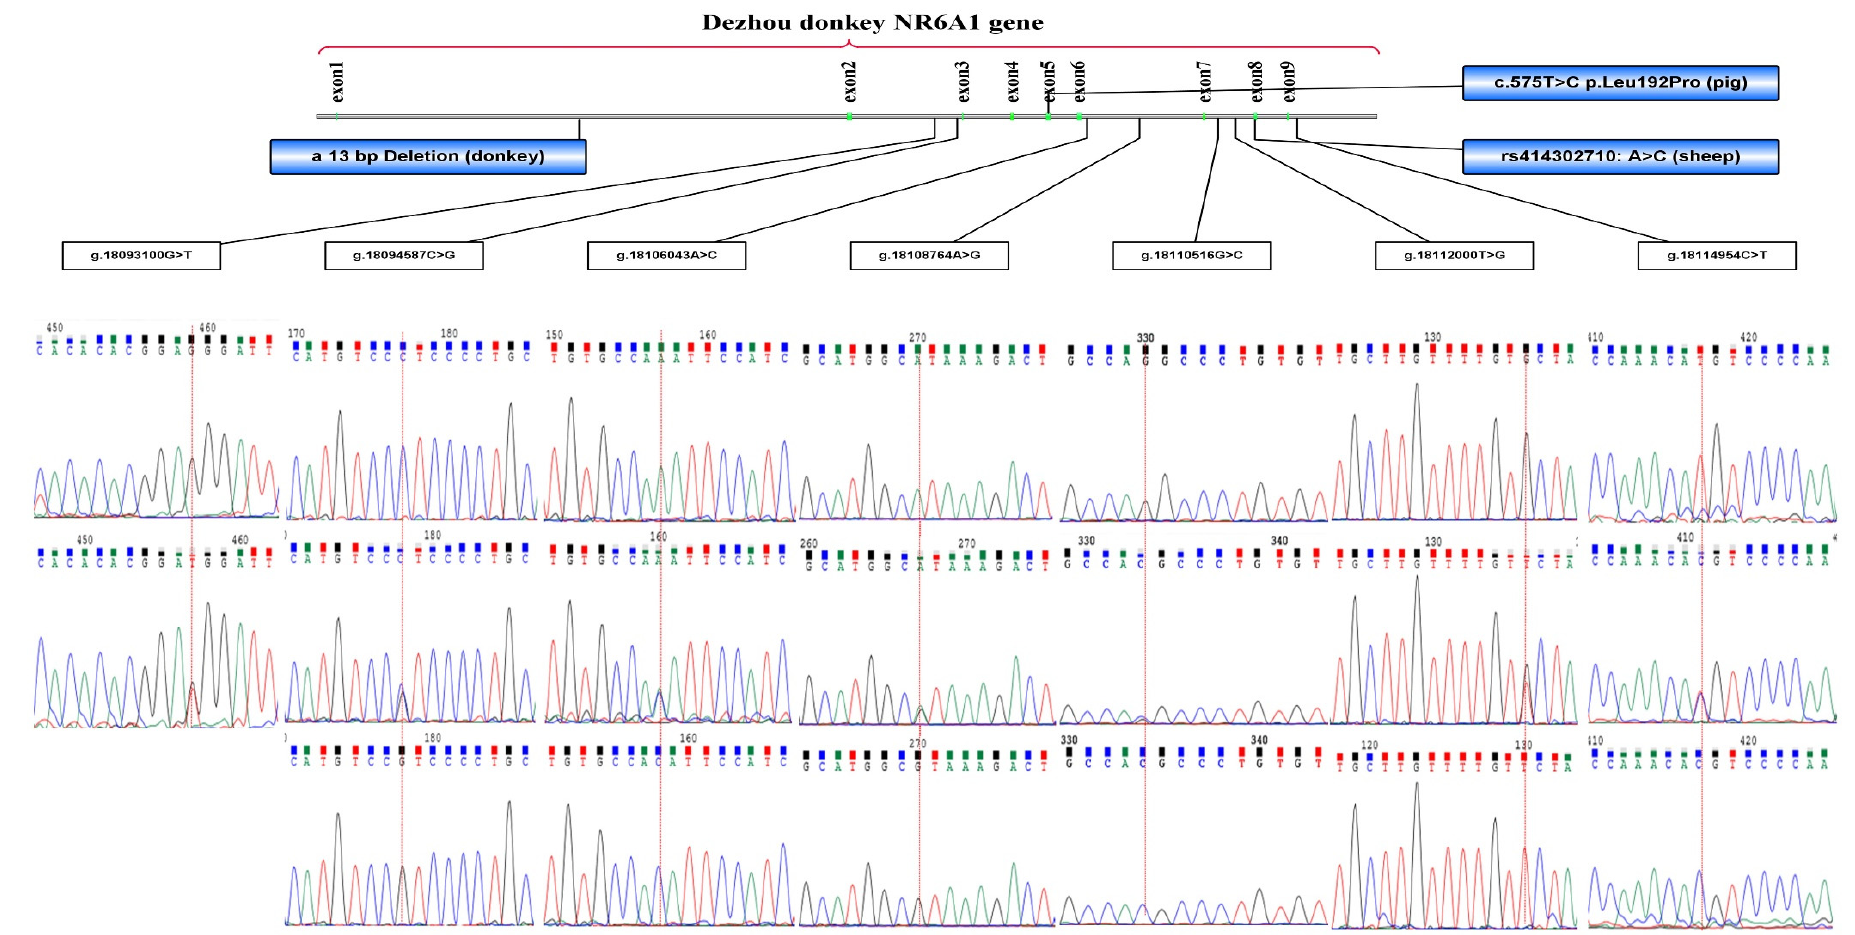
Figure 1. Seven SNVs in the NR6A1 gene of the Dezhou donkey. Note: The red dotted line indicates the peak map of relevant SNV sites.